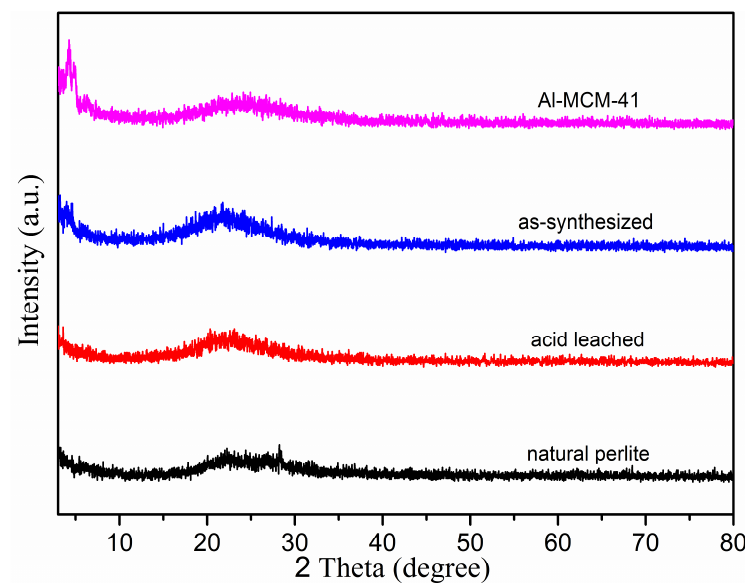
Figure 2. Wide-angle X-ray diffraction ( WAXRD) patterns of samples.